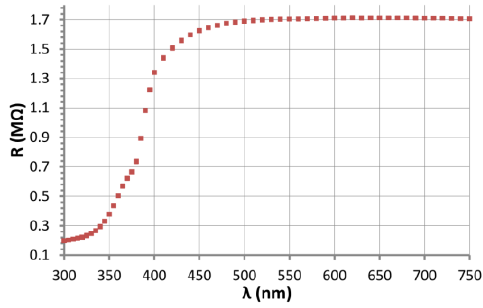
Figure 6. The dependence of the resistance of ZnO nanostructures on the wavelength.